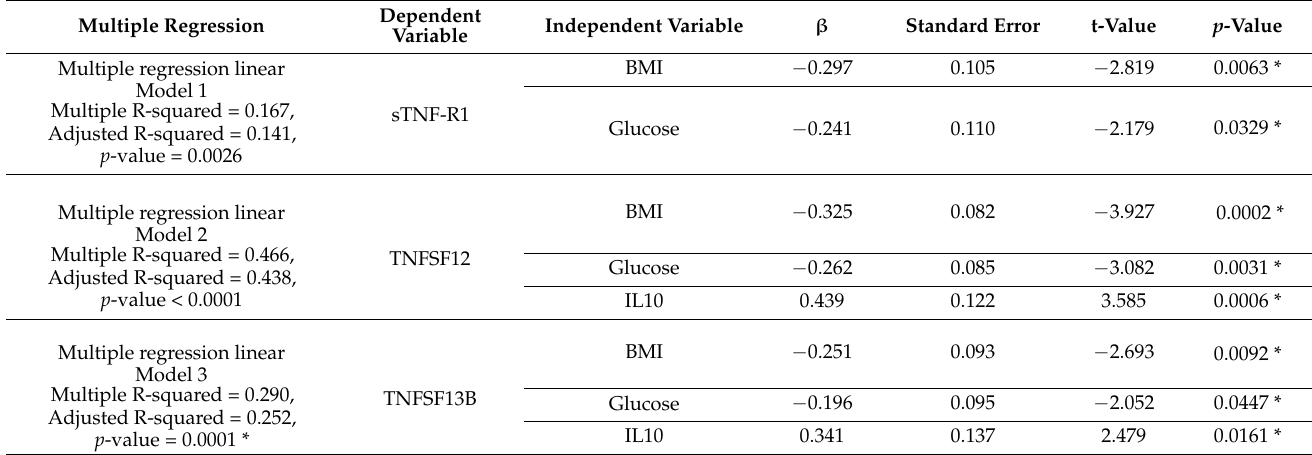
Table 3. Models of multiple regression analysis of the relationship between the sTNF-R1. TNFSF12, TNFSF13B levels and glucose level, IL10 level, BMI.